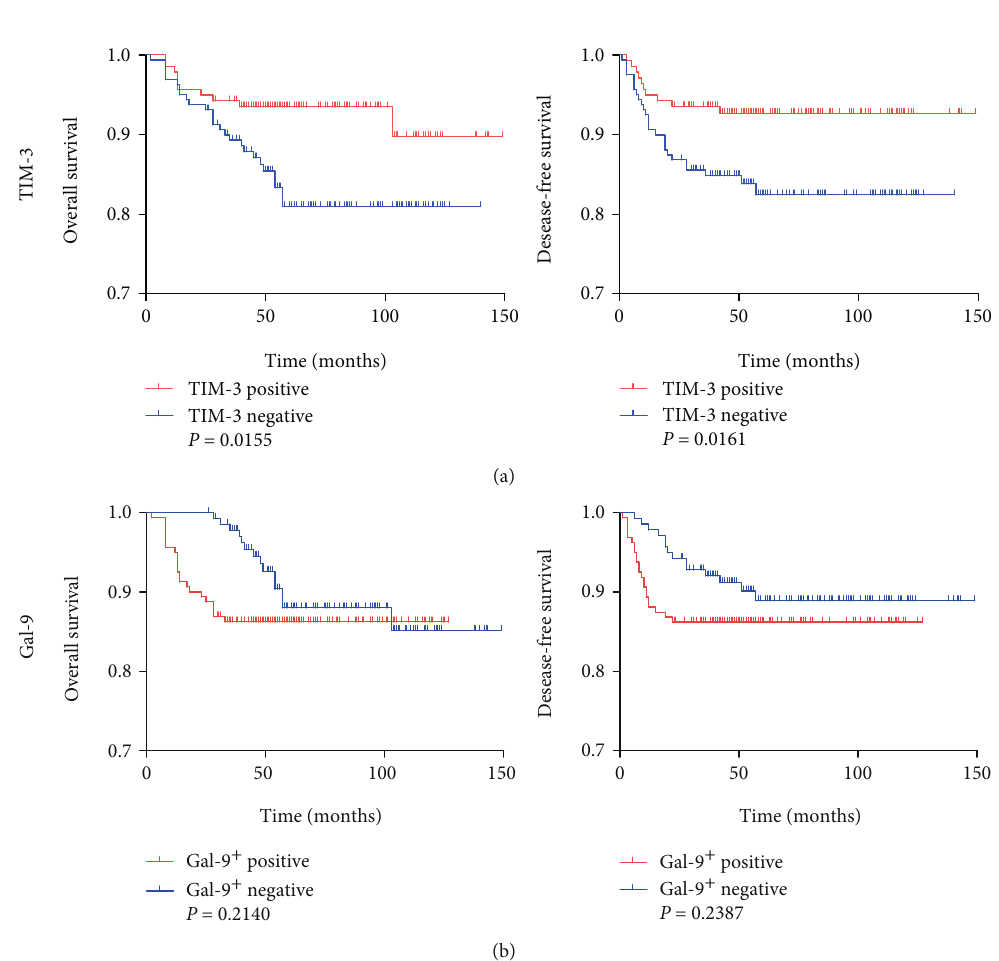
Figure 2: The Kaplan-Meier plots of overall and disease-free survival grouped by TIM-3 + (a) and Gal-9 + (b) TIL densities in GIST. Optimal positive vs. negative values were established by scoring the IHC staining. P values were determined by the log-rank